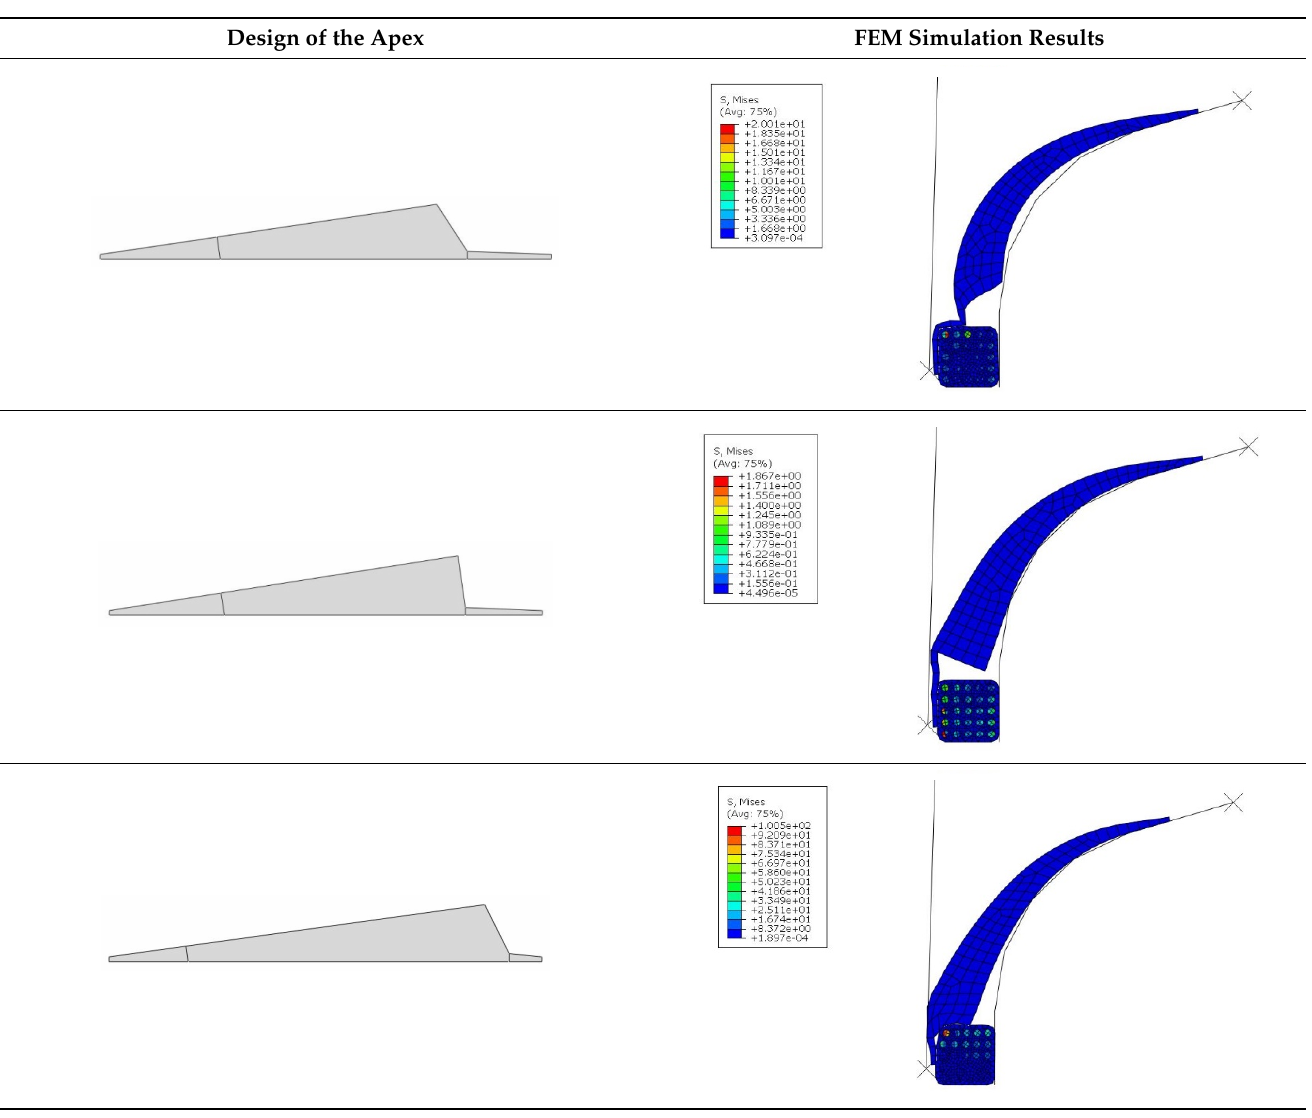
Figure 11. Optimization dataflow. Table 5. Not feasible designs from optimization. Table 5. Not feasible designs from optimization. Table 5. Not feasible designs from optimization.